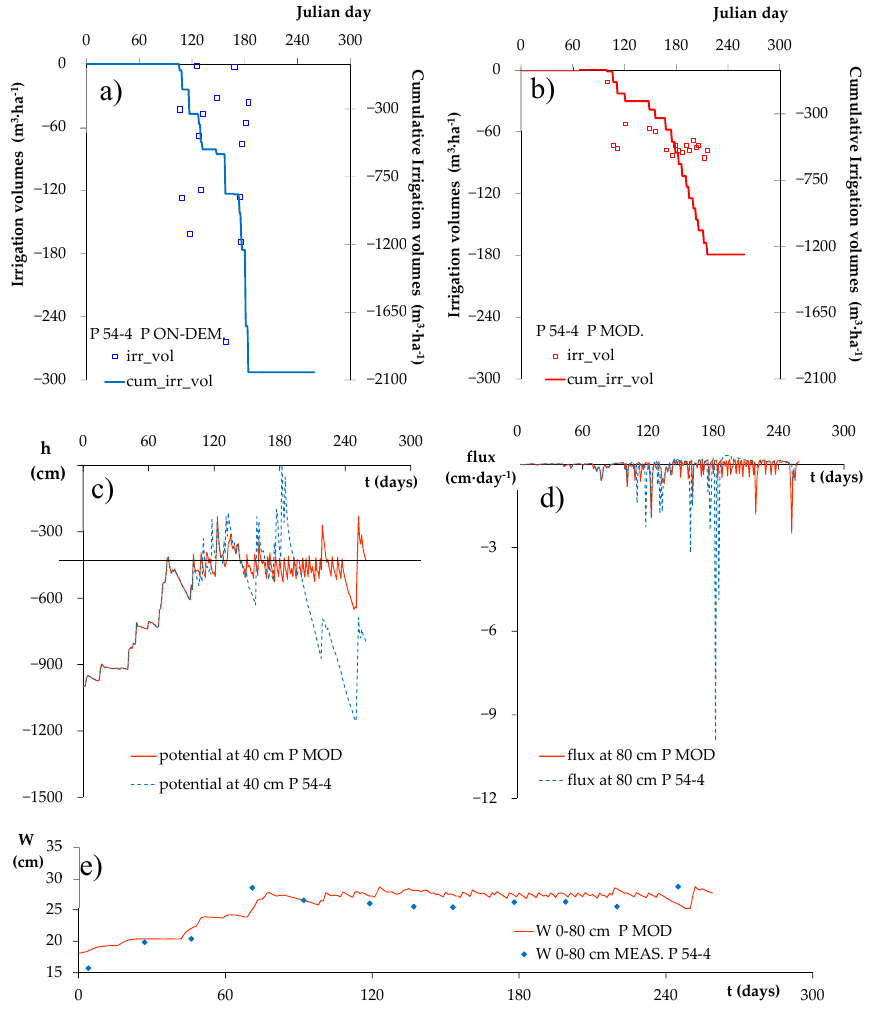
Figure 9. FARM P 54-4. ( a ) The irrigation volumes (both per single day and cumulative) calculated by the model (MOD.); ( b ) the irrigation volumes actually supplied by the farmer (ON-DEM); ( c ) the pressure head at 40 cm depth; ( d ) the percolation fluxes at 80 cm; ( e ) comparison between the time evolution of the water storage predicted by the model (MOD) and that estimated starting from the EMI sensor ECa readings (MEAS).